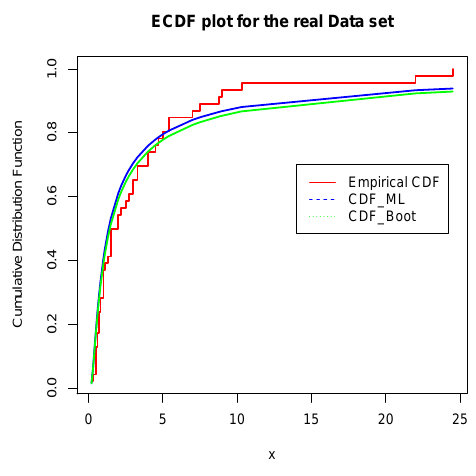
Figure 9 – Empirical CDF plot for the considered data